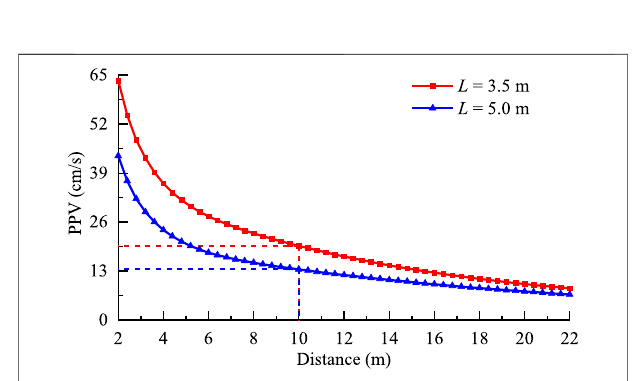
Figure 15A . A signi fi cant reduction of 54% is reached in the PPV. Furthermore, as the excavation radius decreases, the vibration frequency becomes higher, as presented in Figure 15B . This shows that reducing the size of blast-created free surfaces can achieve effective control of the stress release-induced rock vibration.